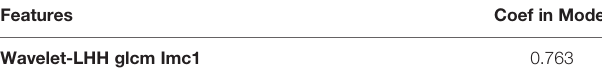
TABLE 10 | The coef fi cients of features in the